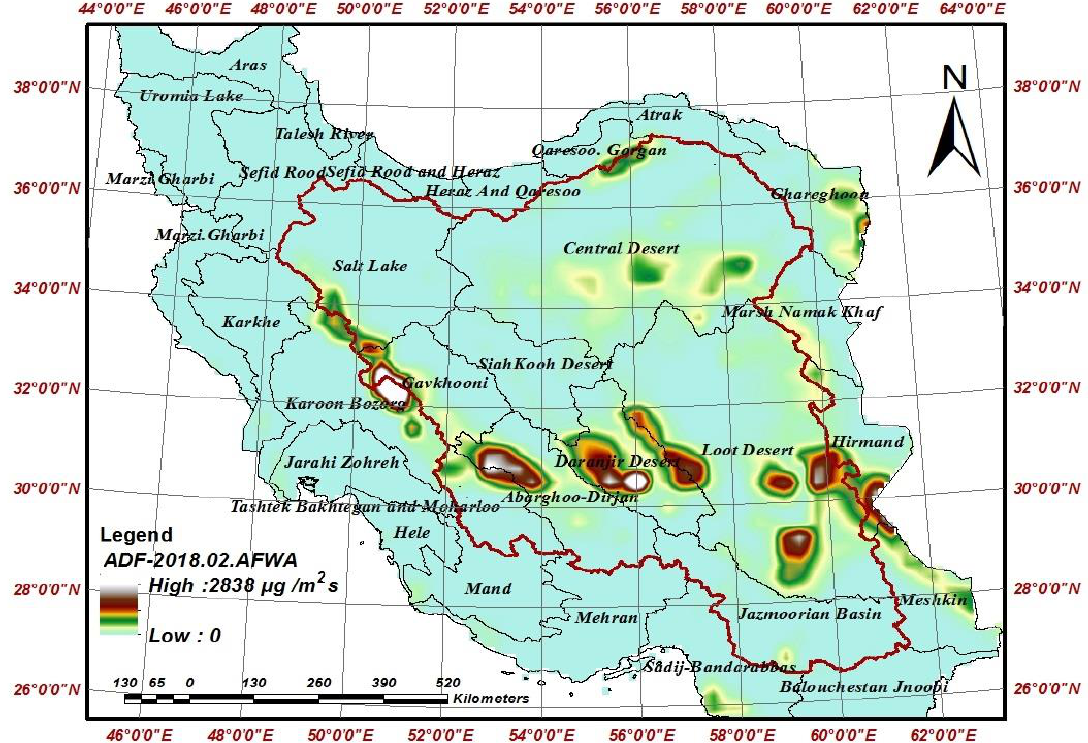
Figure 7. Average of Storm Dust Flux ( µ g / m 2 s) Pattern 14 February 2018 with AFWA scheme.